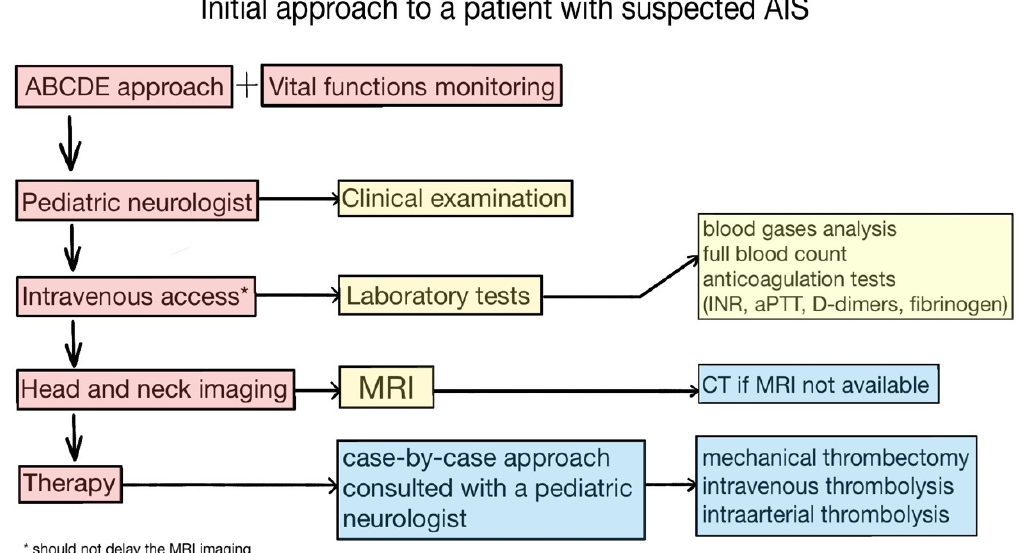
Figure 1. Standardized initial approach to a patient with suspected